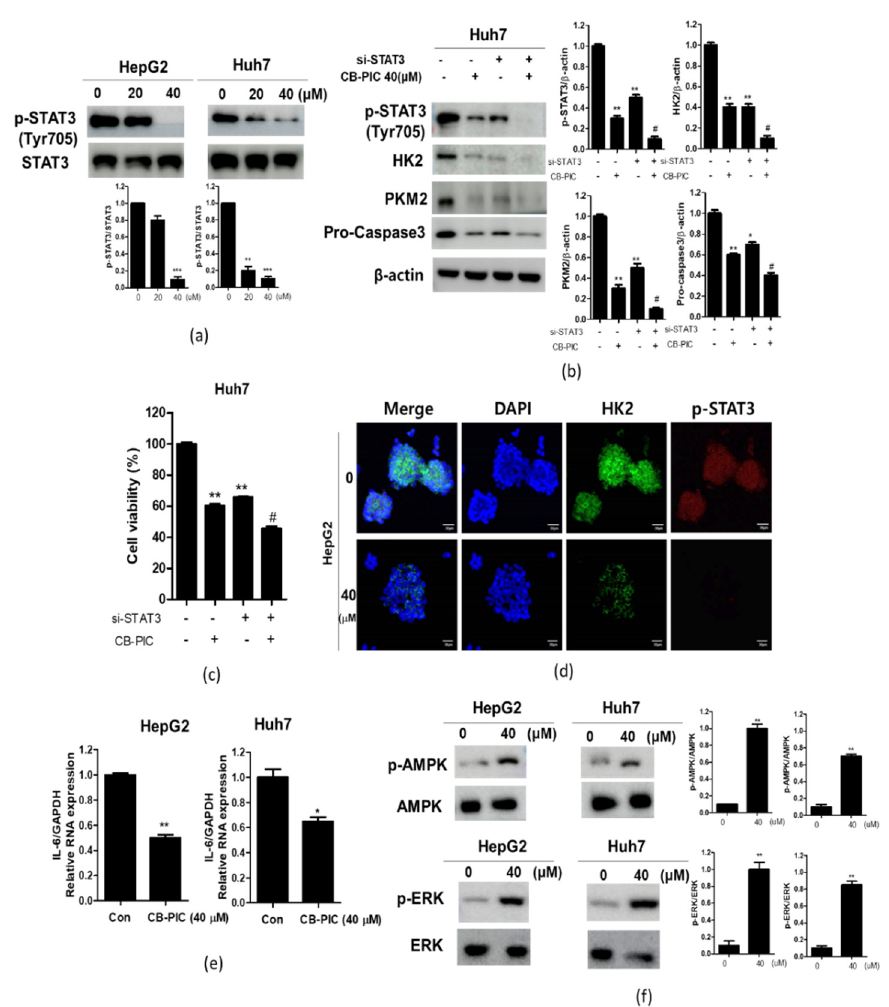
Figure 4. Effect of CB-PIC on the STAT3 signaling in HepG2 and Huh7 cells. ( a ) HepG2 and Huh7 cells were treated with CB-PIC for 24 h. Cell lysates were prepared and subjected to Western blotting for p-STAT3 (Tyr705) and STAT3. Data represent means ± SD. ** p < 0.01, *** p < 0.001 vs. untreated control. ( b ) The effect of STAT3 depletion by using siRNA transfection on p-STAT3, HK2, PKM2, and pro-caspase3 in the CB-PIC-treated Huh-7 cells. The cells transfected with p-STAT3 or scram-led siRNA (40 nM) for 24 h were exposed to CB-PIC (40 µ M) for 24 h, and they were subjected to Western blotting for p-STAT3, HK2, PKM2, and pro-caspase3. ** p < 0.01, vs. untreated control. # p < 0.01 vs. CB-PIC alone control. ( c ) The effect of STAT3 depletion on the viability of Huh7 cells by MTT assay. Data represent means ± SD. * p < 0.05, ** p < 0.01, *** p < 0.001 vs. untreated control. # p < 0.01 vs. CB-PIC alone control. ( d ) The effect of CB-PIC on STAT3 and HK2 in HepG2 and Huh7 cells by immunofluorescence. Immunofluorescence staining was conducted with anti-phospho-STAT3 and HK2 antibodies and secondary FITC-conjugated antibody ( e ) The effect of CB-PIC on IL-6 mRNA expression in HepG2 and Huh7 cells by qRT-PCR. Data represent means ± SD. * p < 0.05, ** p < 0.01, vs. untreated control. ( f ) HepG2 and Huh7 cells were treated with CB-PIC (0, 40 µ M) for 24 h. Cell lysates were prepared and subjected to Western blotting for p -AMPK, AMPK, p-ERK, and ERK. Graphs represent relative level of protein expression/ β -actin ot total protein. ** p < 0.01, vs. untreated